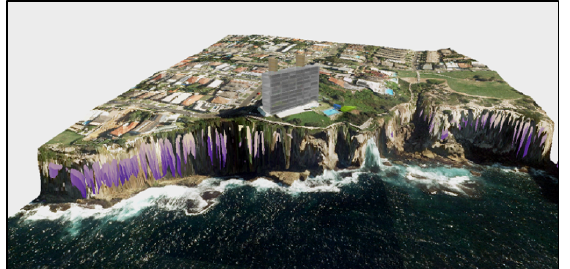
the final LandXML.